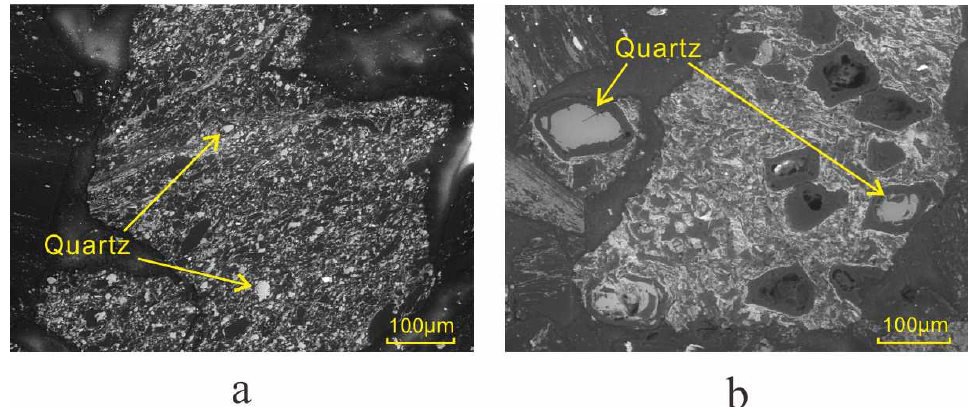
Figure 3. SEM back-scattered electron images of quartz in the Huainan coalfield. ( a ) Quartz occurring as sub-rounded particles embedded in kaolinite matrix, S15, Pan1 (P1) mine, No. 8 coal seam; ( b ) quartz occurring as pore space infillings in a dissolved pore, S10, Guqiao (GQ) mine, No. 8 coal seam.